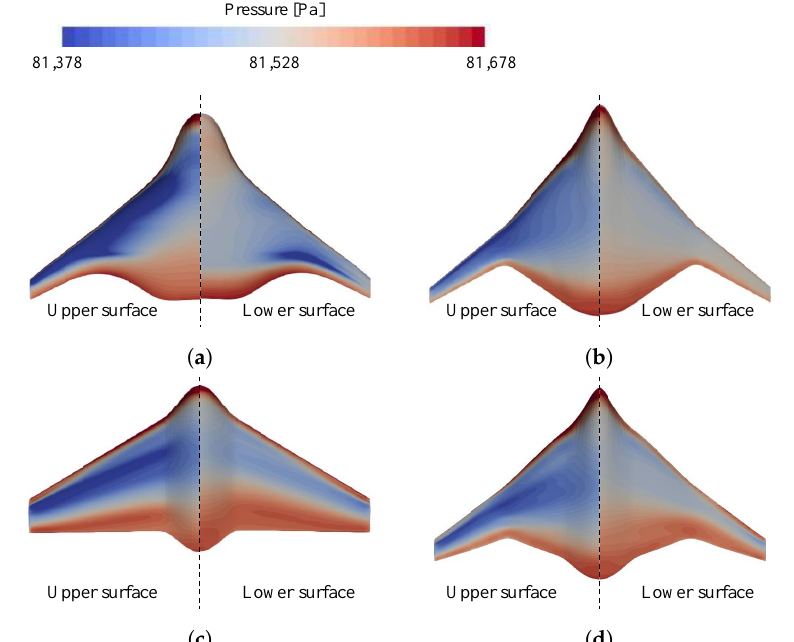
Figure 15. The distributions of the pressure on the surfaces of the baseline and optimal models. For each figure, the left and right contours show the pressure on the upper and lower surfaces of the BWB aircraft, respectively. ( a ) Baseline model 1, ( b ) Baseline model 2, ( c ) Baseline model 3, and ( d ) the optimal model.